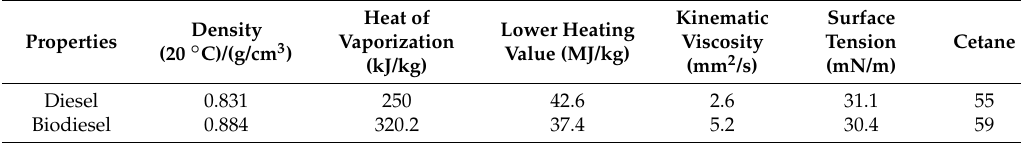
Table 3. Physical and chemical properties of alternative